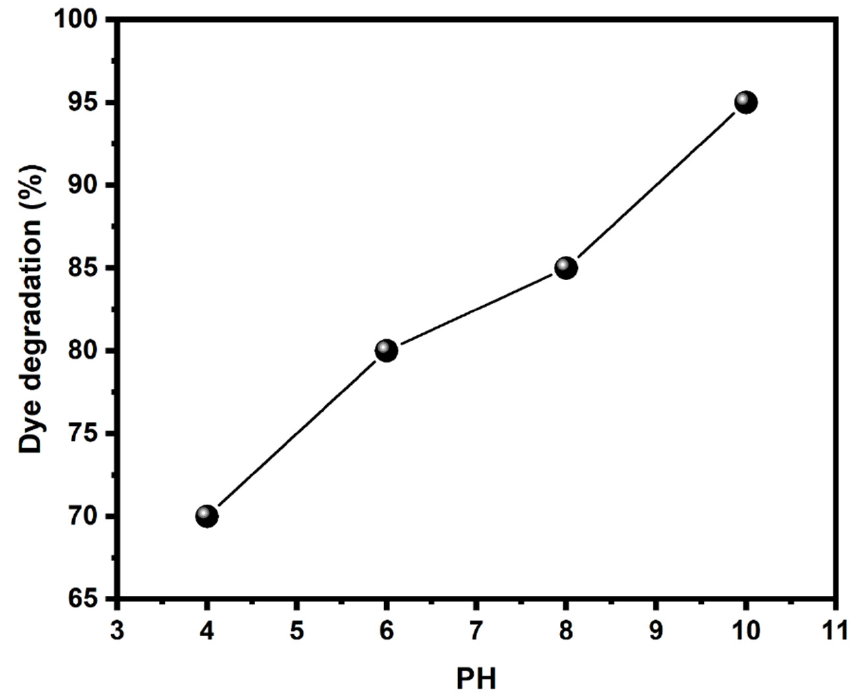
Figure 8. Effect of PH on degradation bromophenol blue.